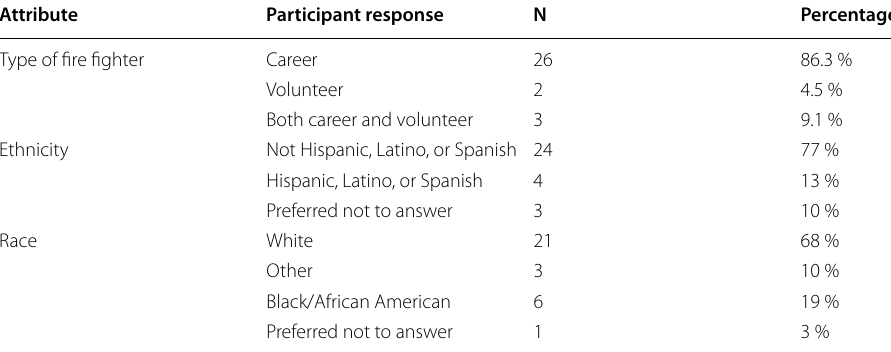
Total participants